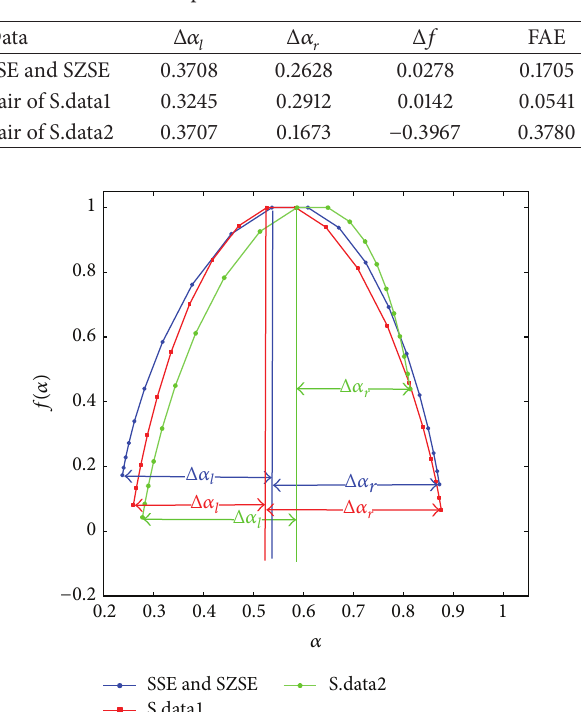
Table 3: Multifractal spectra for real markets and simulated data.